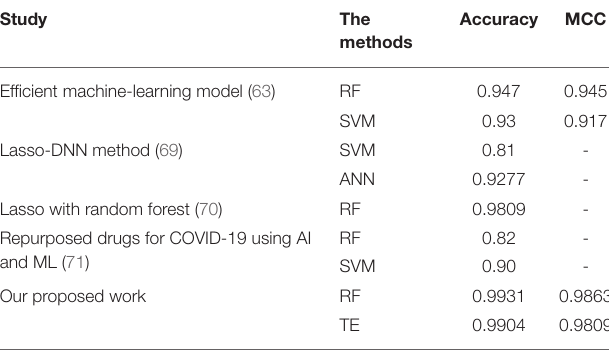
TABLE 2 | Model performance comparison between related and our